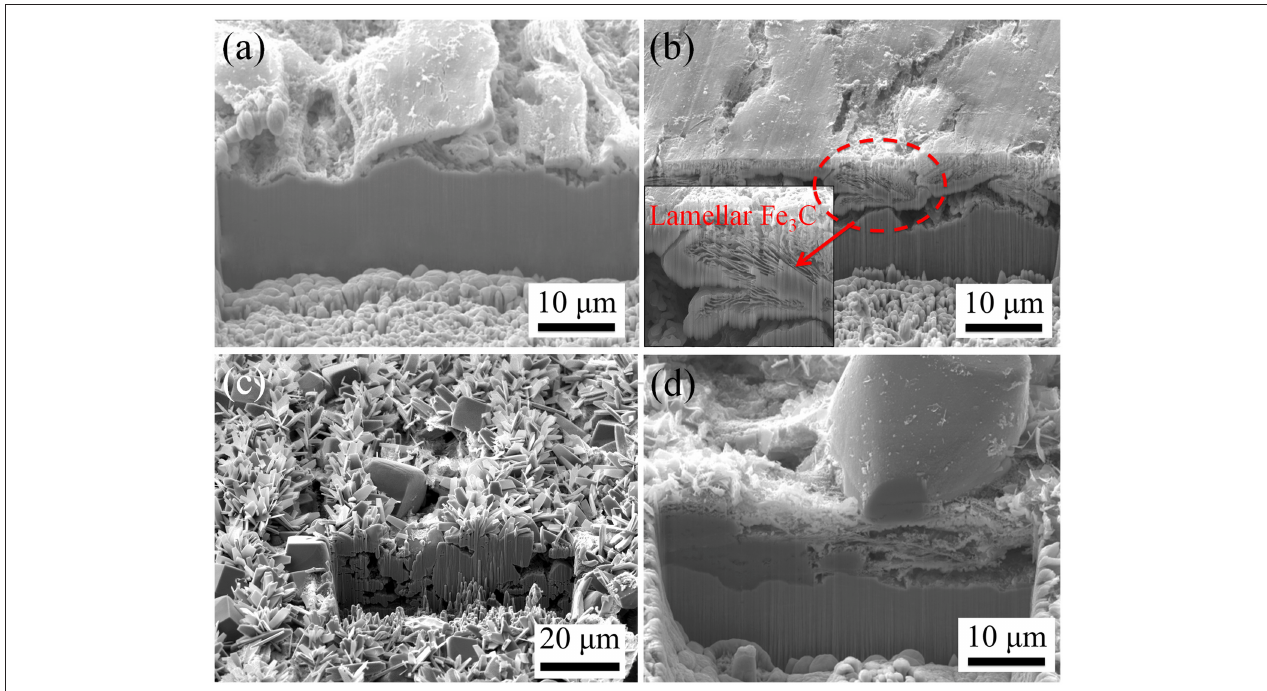
FIGURE 8 | Cross-sectional morphologies of the corrosion product layers on C1018 samples tested in 1% NaCl solutions maintained at (a) 25 ◦ C, (b) 40 ◦ C, (c) 60 ◦ C, and (d) 80 ◦